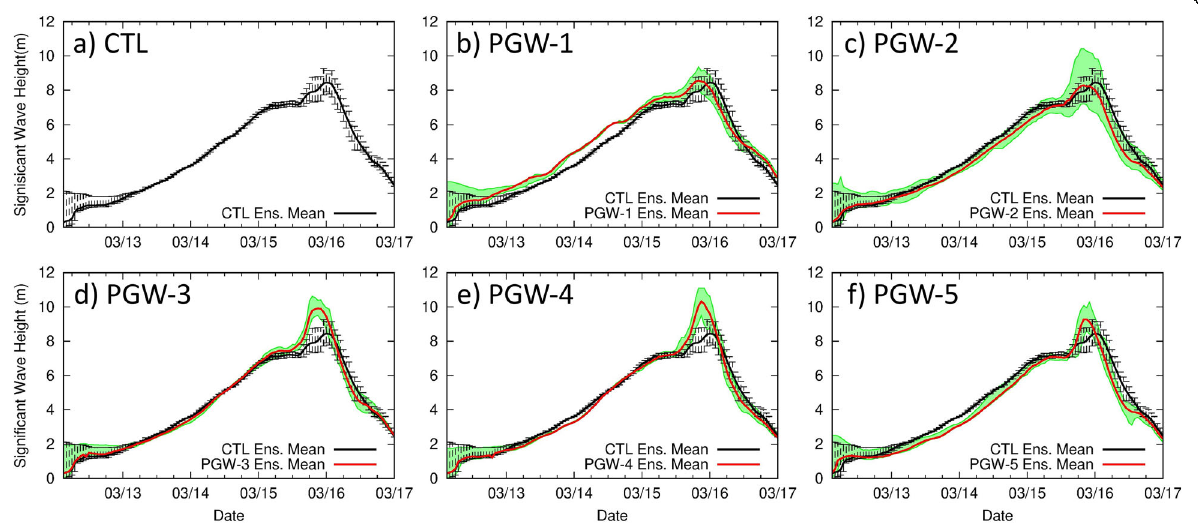
Fig. 13 Temporal variation in the significant wave height over the offshore region of Suva. a The result of CTL. Black line and dashed vertical bars indicate the ensemble mean value and the ensemble spread, respectively. b – f The results of each PGW simulation. The red line and the green shading represent the ensemble mean value and the range of the ensemble spread, respectively. The result of the CTL is also shown in each